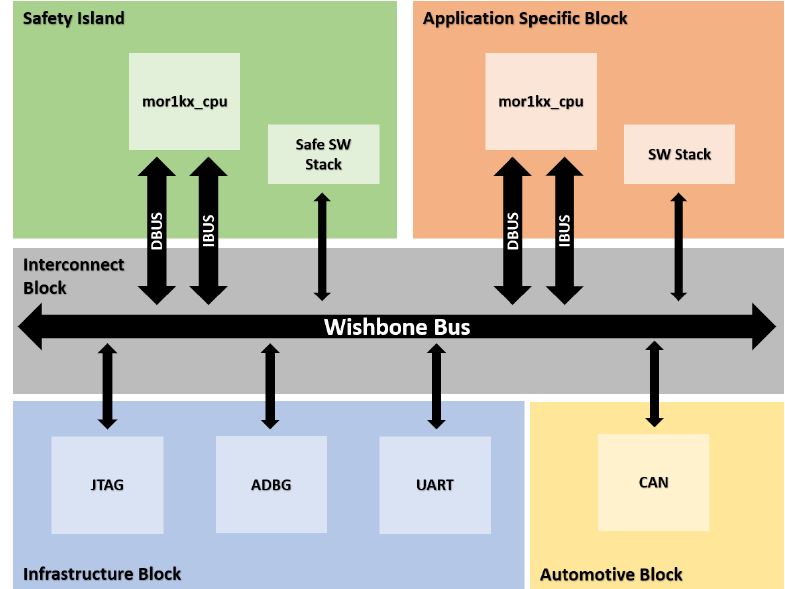
Figure 6. AutoSoC functional